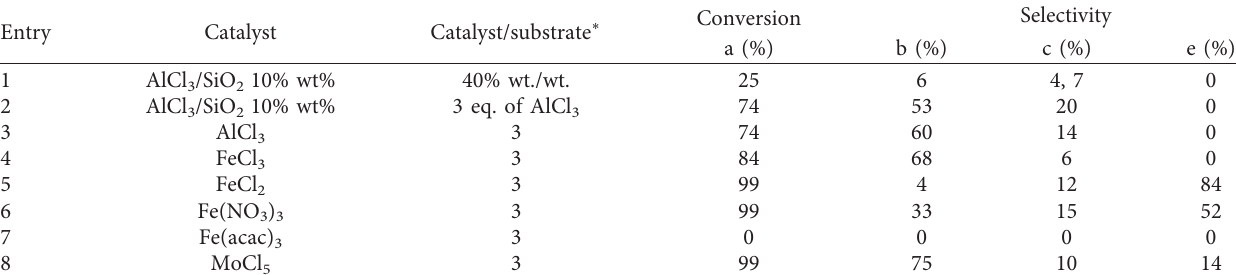
Scheme 2: Allylic chlorination of carvone. Table 1: Allylic chlorination of carvone using different Lewis acid catalysts.